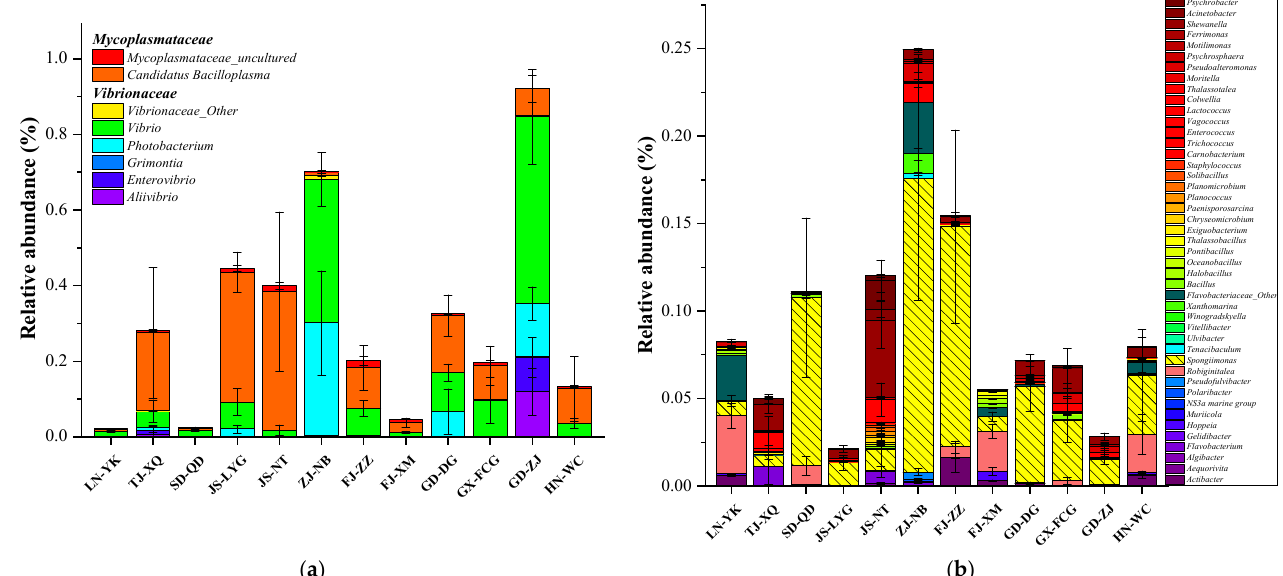
Figure 4. Relative abundances (at the genus level) of potential pathogenic bacteria ( a ) and spoilage organisms ( b ) in the intestine of L. vannamei (mean, n = 3).